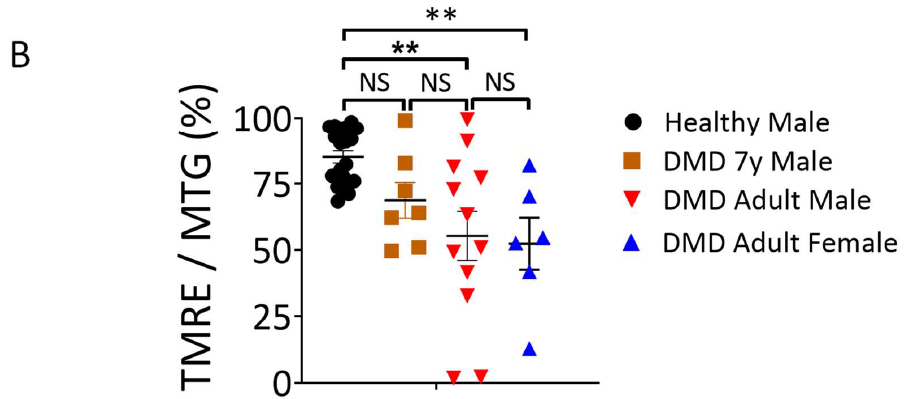
Figure 7. Mitochondrial activity in beating iPSC-CMs. ( A ) Representative images of mitochondria in healthy, DMD 7-year-old (7y), DMD adult male and adult female CMs simultaneously stained with three fluorescent dyes: MTG (green; ΔΨ independent), TMRE (red; ΔΨ dependent) and Hoechst (blue; nuclear staining for live cells). Scale bar, 8 μm. ( B ) Quantification of total mitochondrial activity calculated by the ratio of the volume of fluorescence (TMRE/MTG) for each Z-stack image. The summary shows a significant decrease in DMD adult male and female CMs compared to healthy and DMD 7y CMs. Healthy, n = 7; DMD 7y, n = 6; DMD adult male, n = 12; DMD adult female, n = 6. The Shapiro–Wilk test of normality was applied for all metabolites to assess whether the data were normally distributed; One-way ANOVA, NS = non-significant, ** p < 0.01.